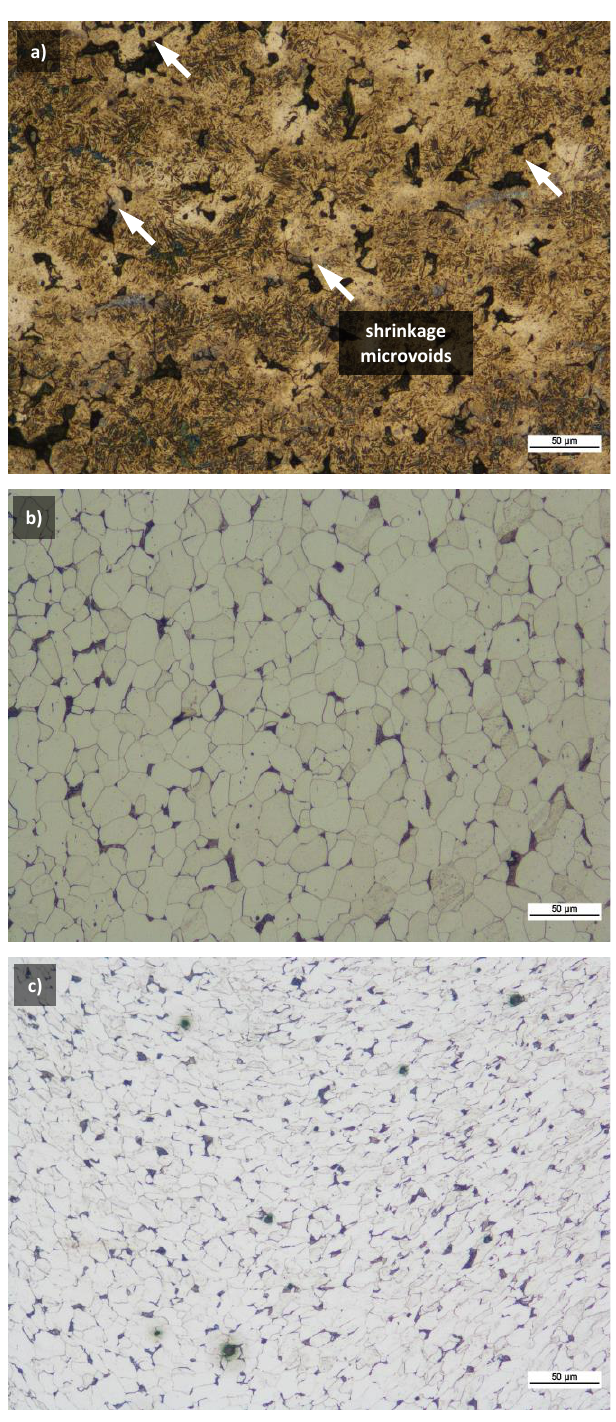
Fig. 5. Sleeve of the central fastener: a) the original with tempered marten- site microstructure with visible numerous porosities and shrinkage micro- cavities; b) c) an imitation of the original with ferritic-pearlitic microstruc- ture with visible locally occurring deformation grain texture resulting